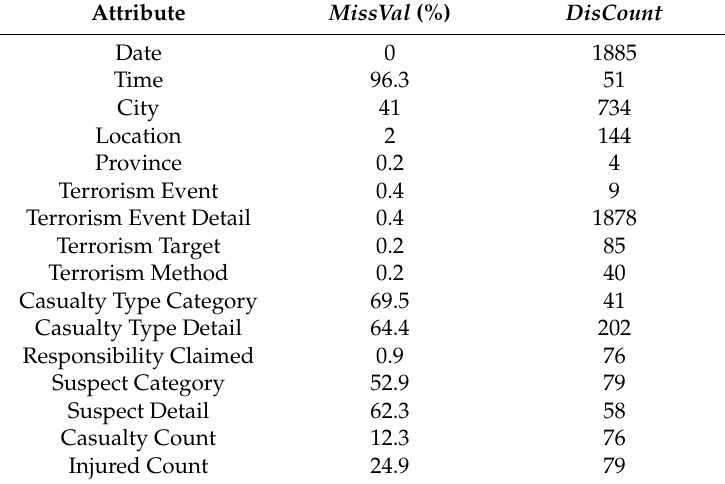
Table 2. Missing and unique values for our initial dataset; Attribute = attribute label, MissVal = Percentage of missing values, DisCount = Number of discretized